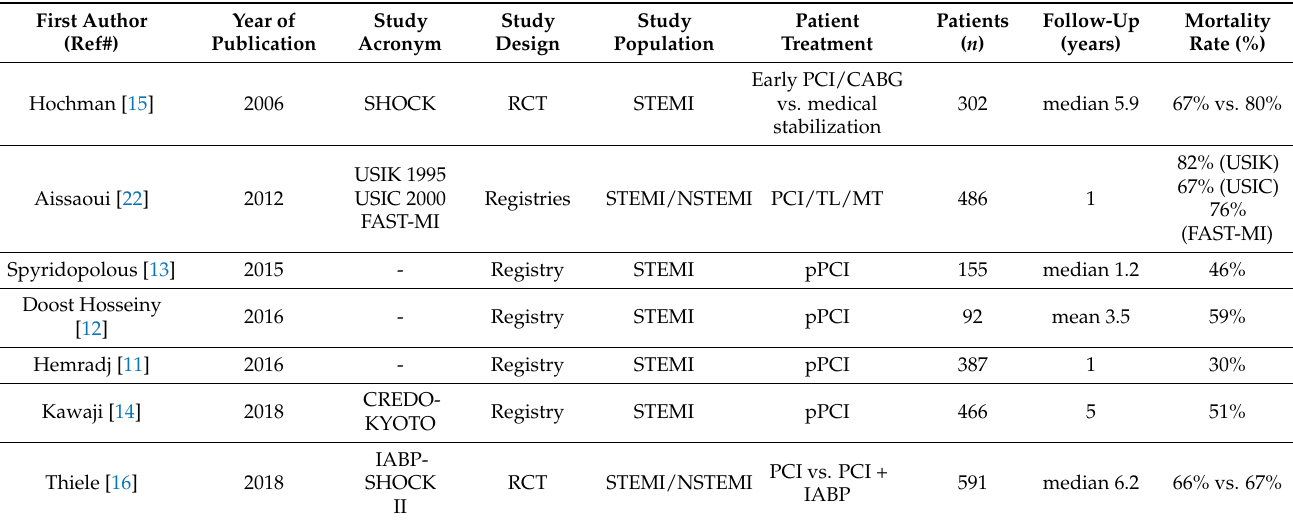
Table 3. Characteristics of studies investigating the impact on long-term mortality of acute myocardial infarction complicated by cardiogenic